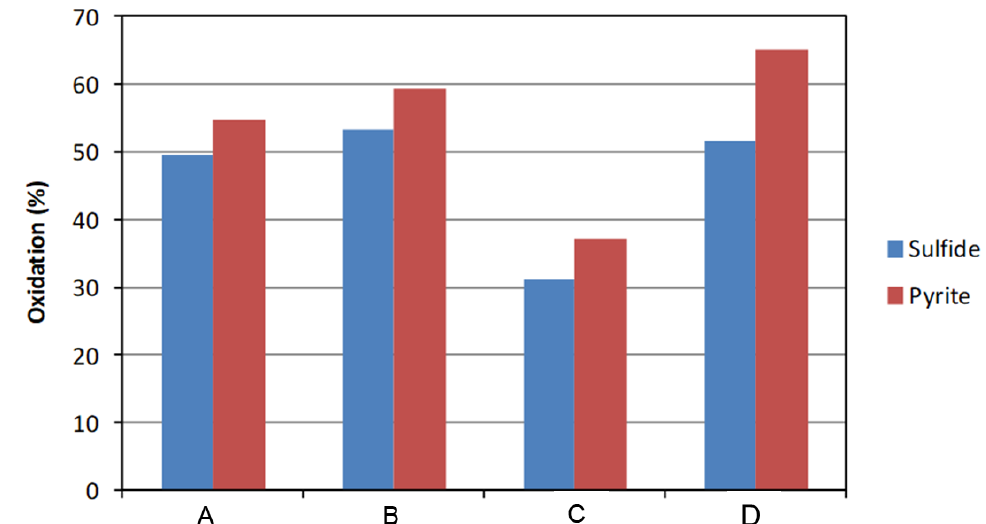
Figure 11. Calculated oxidation of sulfide and pyrite based on total-sulfide analysis and QXRD analysis considering mass loss during the experiment for reactors A – D .